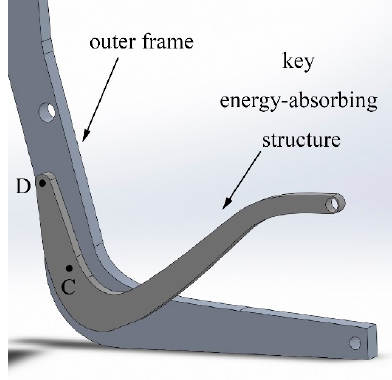
Figure 2. Partial enlargement of main structures.